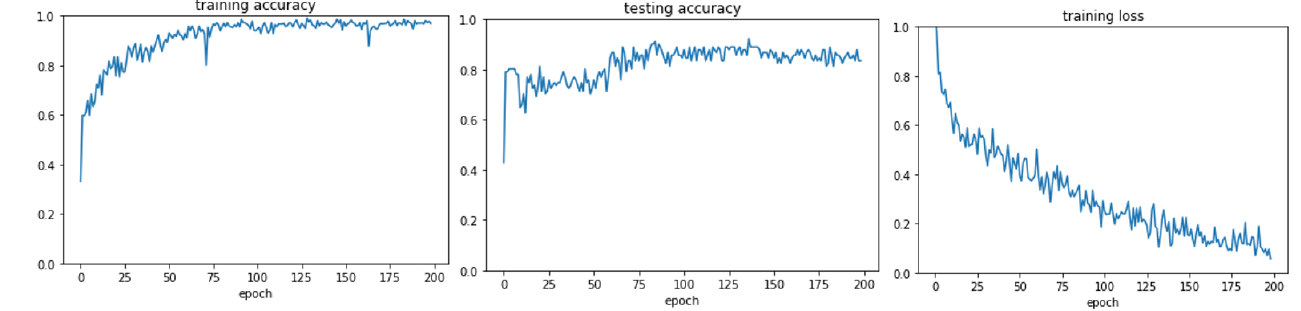
Figure 3. Training accuracy, testing accuracy, and training loss for GraphChrom, 200 epochs, learning rate = 0.001, Adam optimizer, n_hubs = 6.